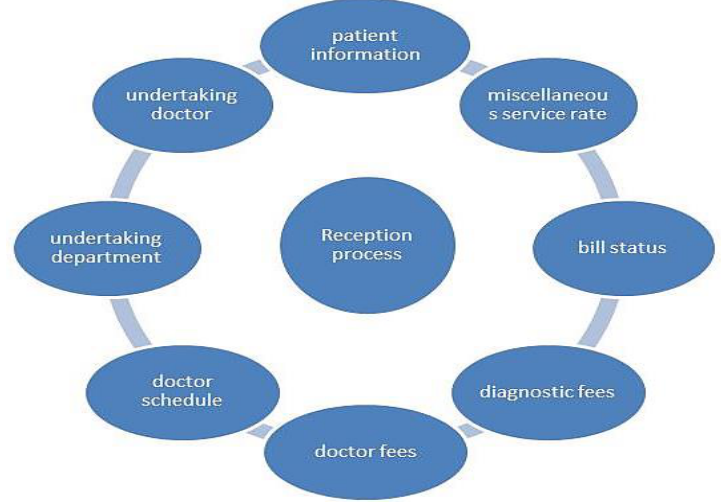
Fig. 21. Data flow of the reception